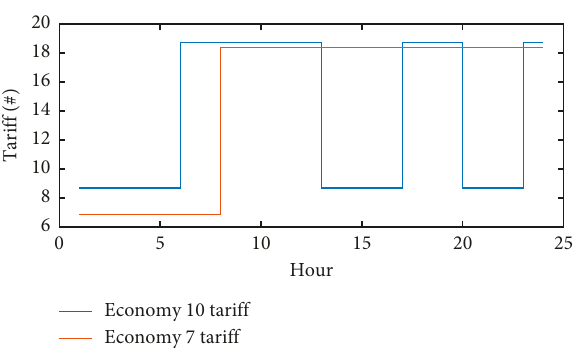
Figure 7: Wind speed at the wind farm.